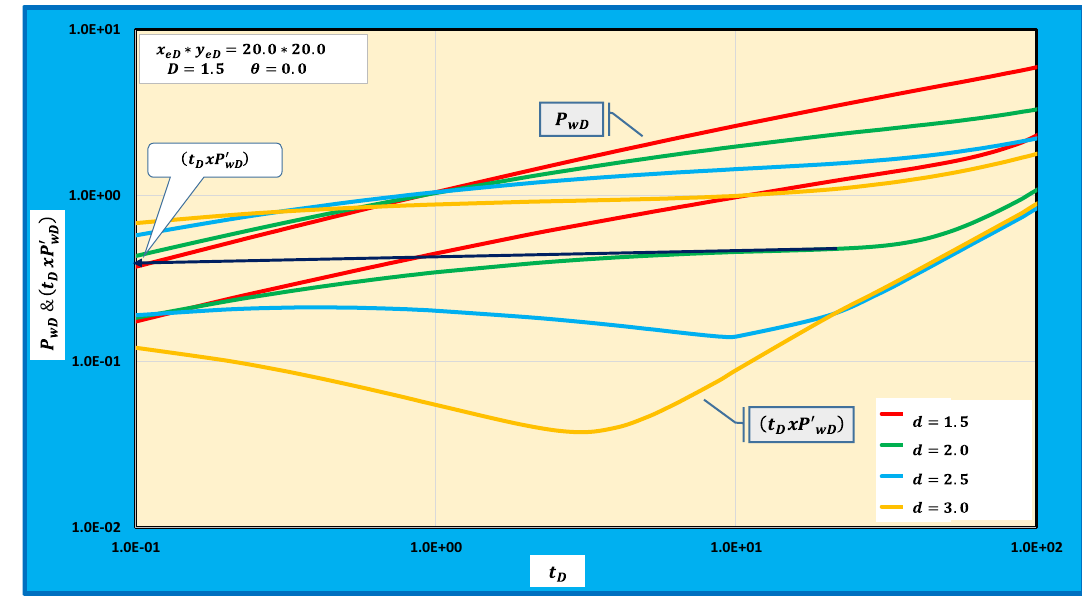
Fig. 24 Pressure and pressure derivative during pseudo-radial flow regime for different fractal dimensions